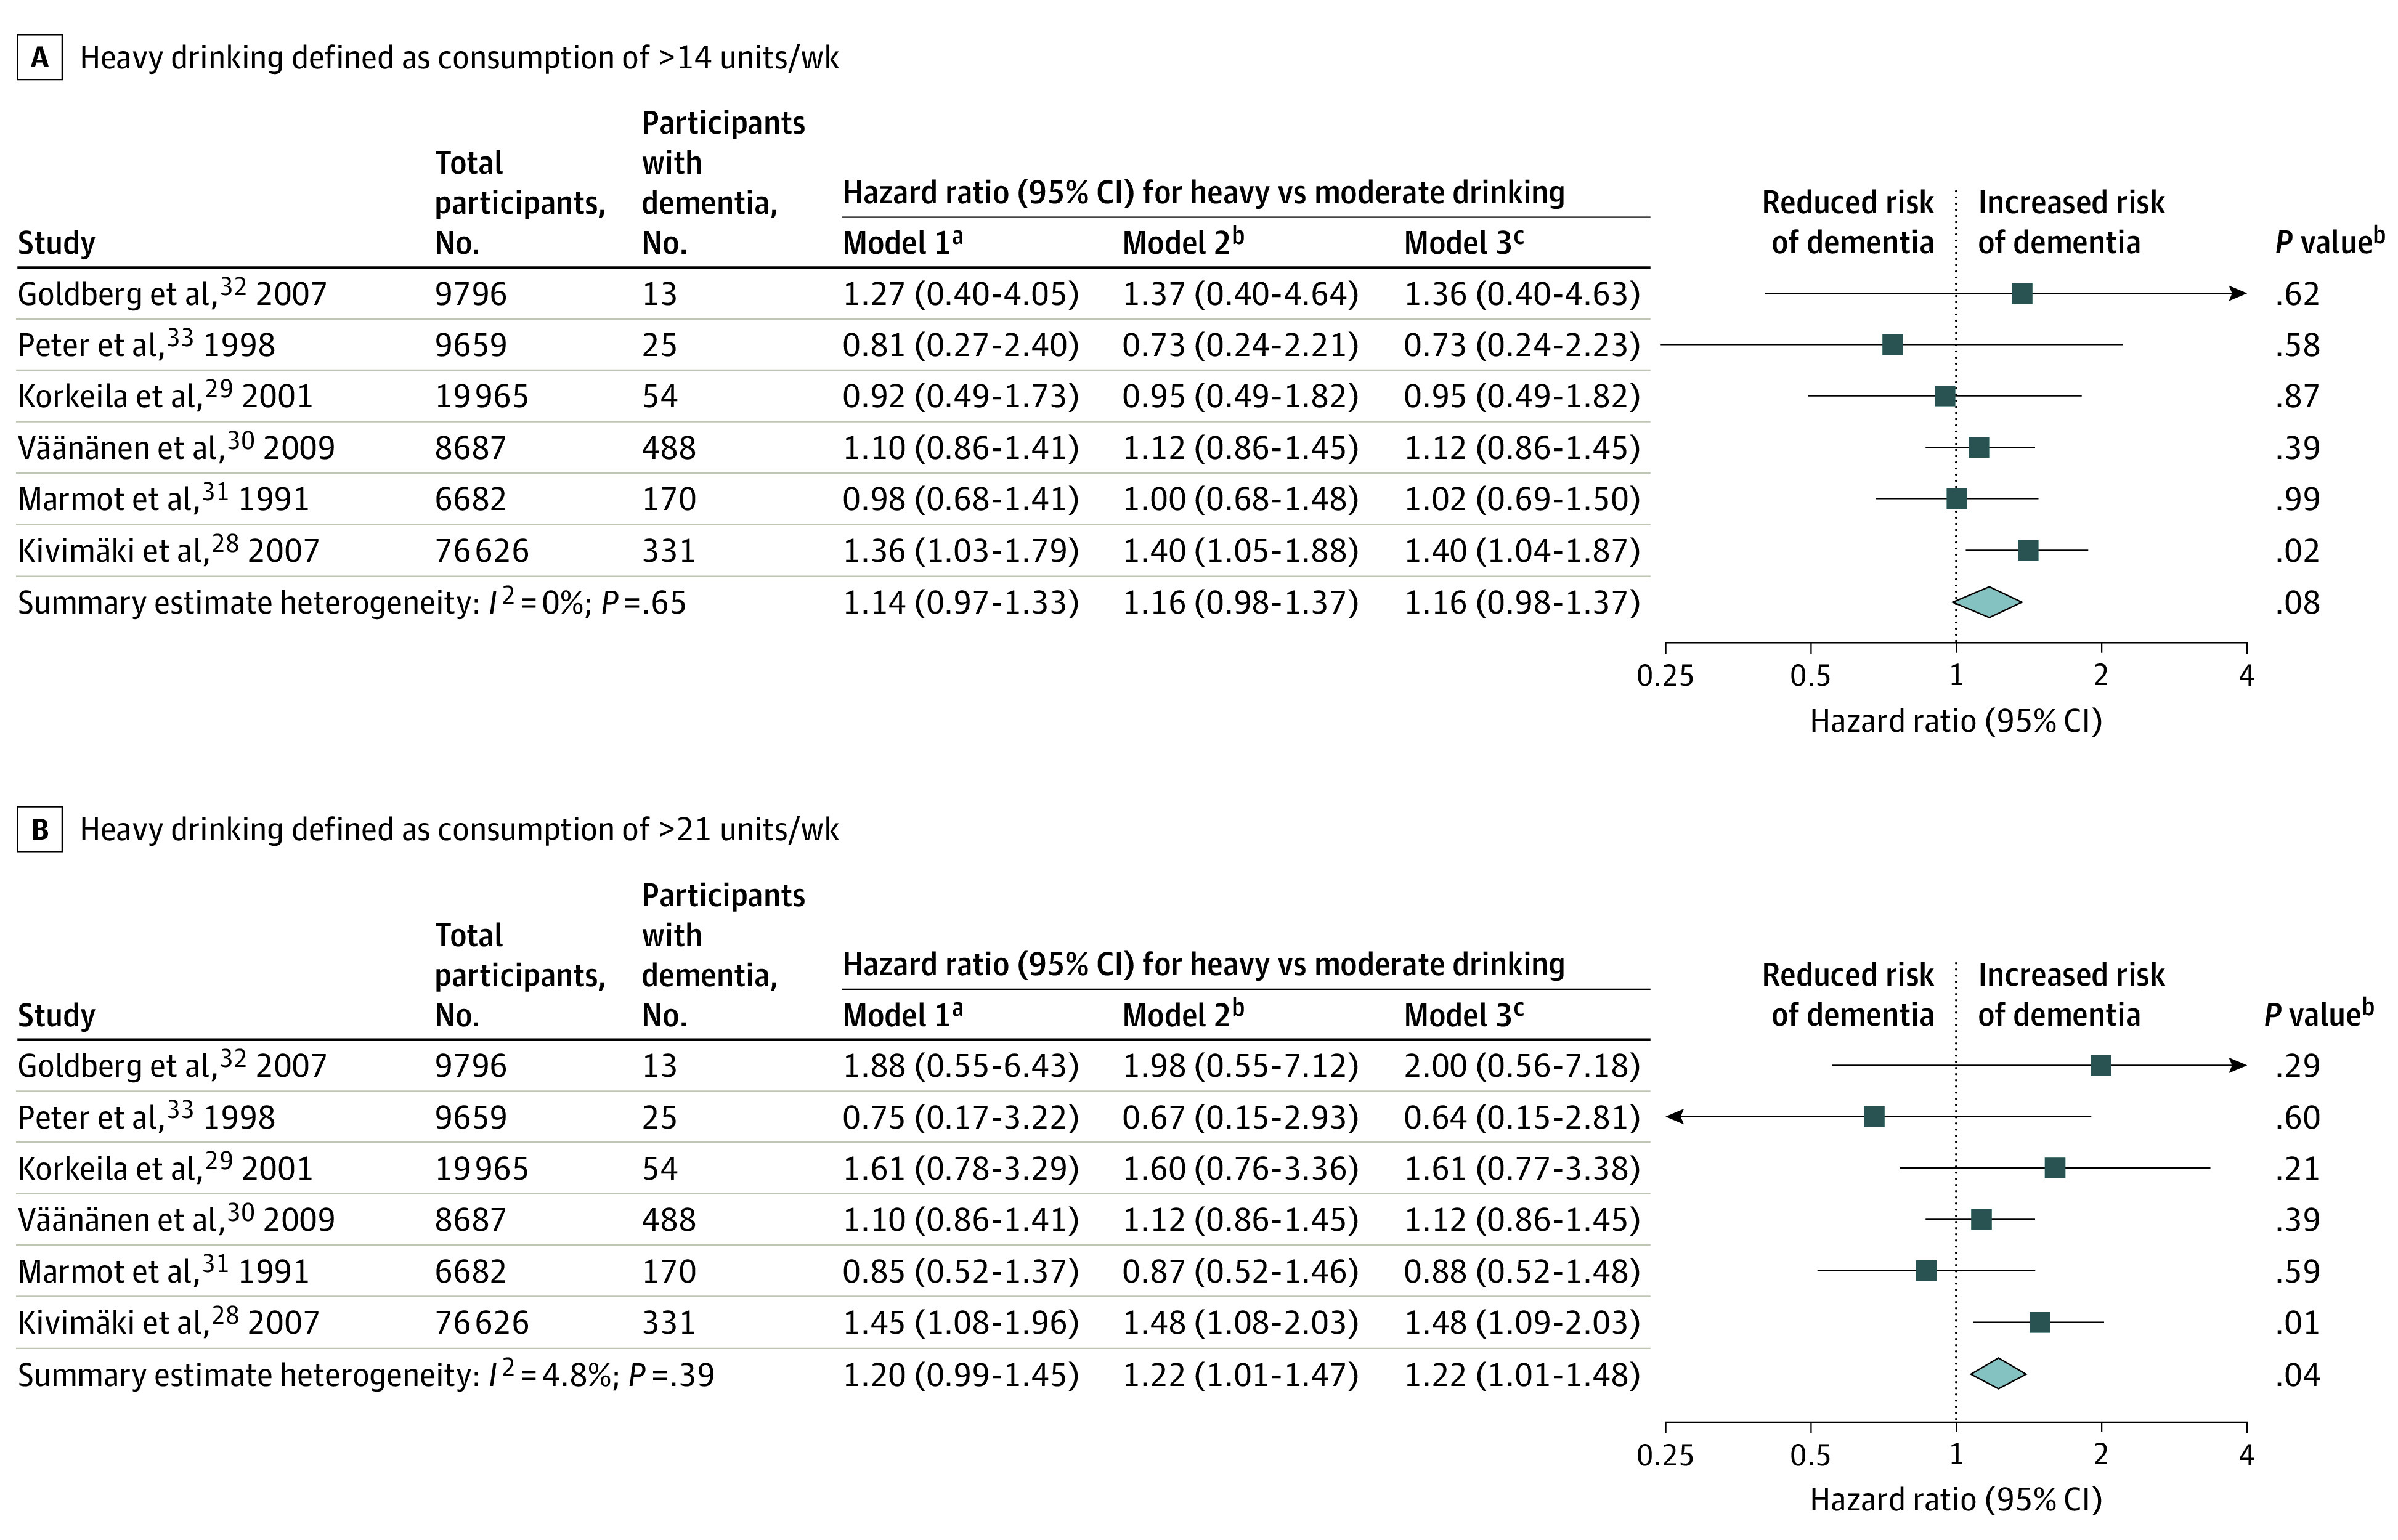
Meta-analysis of Association Between Overall Alcohol Consumption and Risk of Incident DementiaHeavy drinking was defined using current UK Chief Medical Officers35 (A) and US National Institute of Alcohol Abuse and Alcoholism36 (B) definitions.aModel 1 was adjusted for age, sex, educational level, and occupational position.bModel 2 was adjusted for the factors included in model 1 and additionally adjusted for smoking, body mass index, and physical activity.cModel 3 was adjusted for the factors included in model 2 and additionally adjusted for hypertension and diabetes.